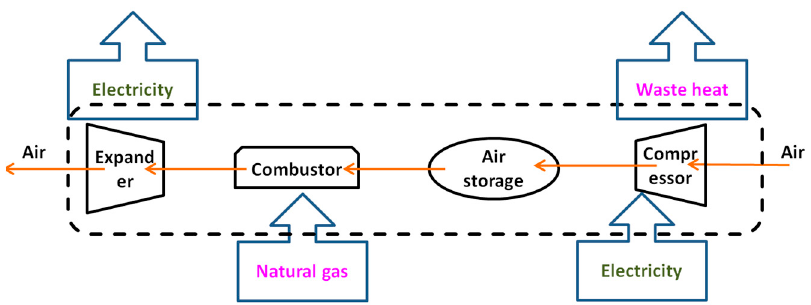
Figure 1. Schematic of a generic conventional compressed air energy storage (CAES) system.